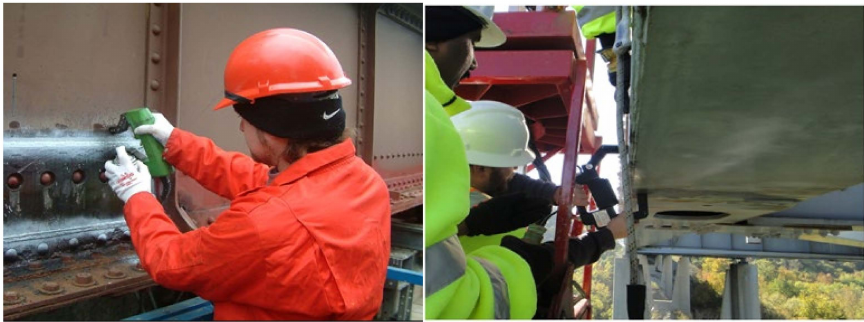
Figure 5. Application of magnetic particle testing for steel bridges